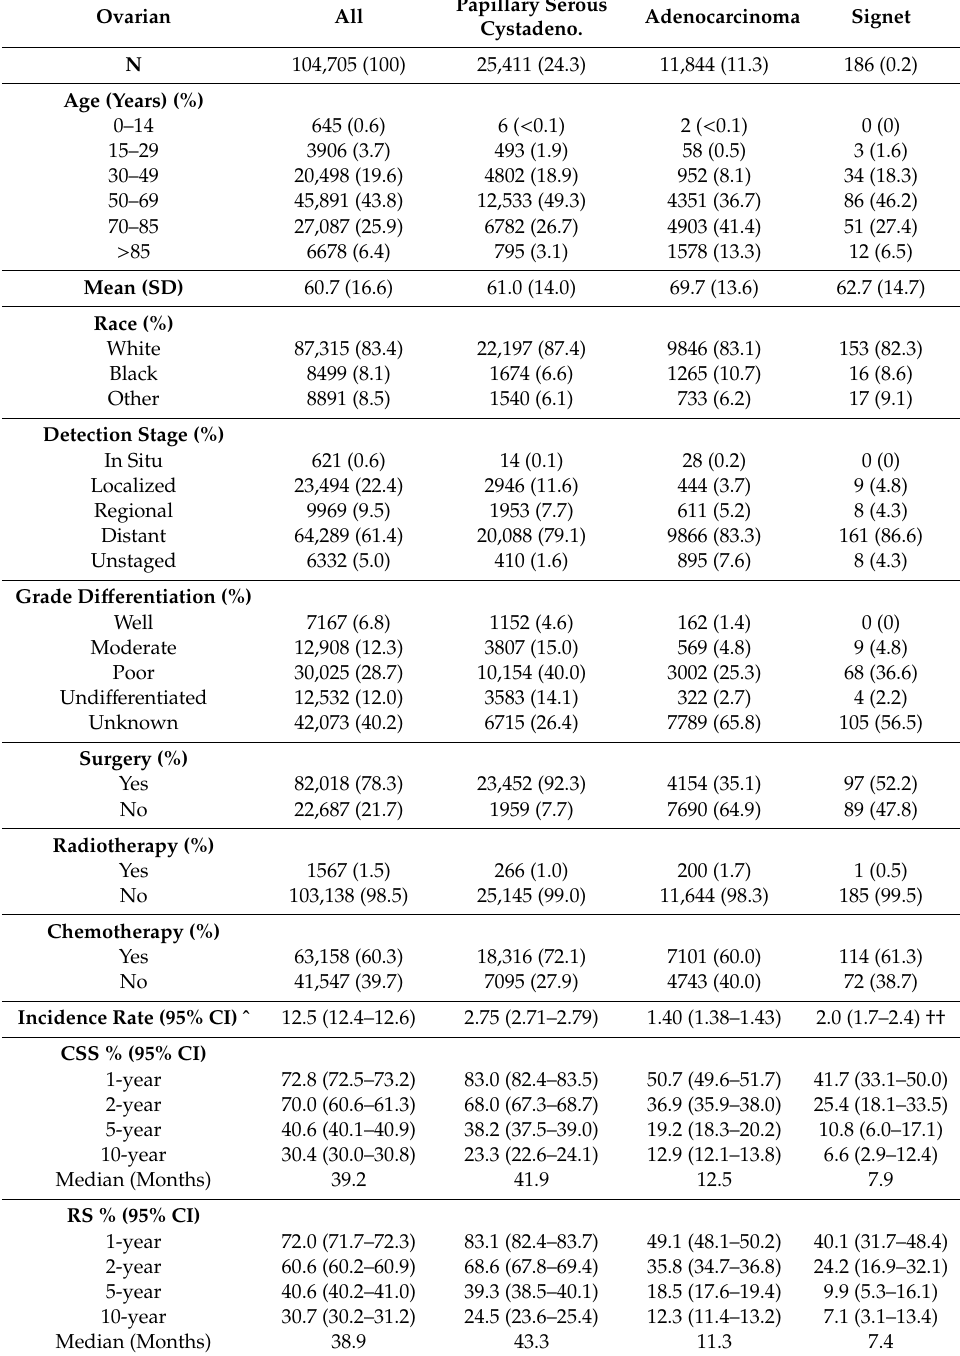
Table 23. Baseline demographics and clinical characteristics by histology for ovarian cancers. Papillary Serous Ovarian All